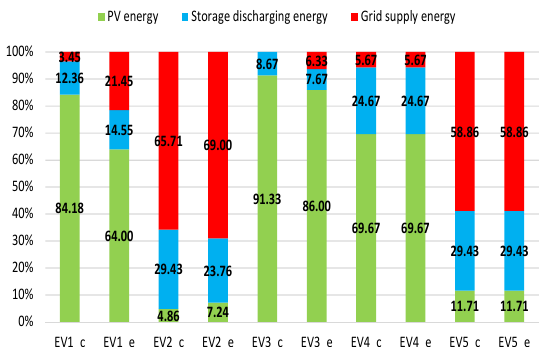
Figure 25. EVs energy distribution for Scenarios 2c and 2e.